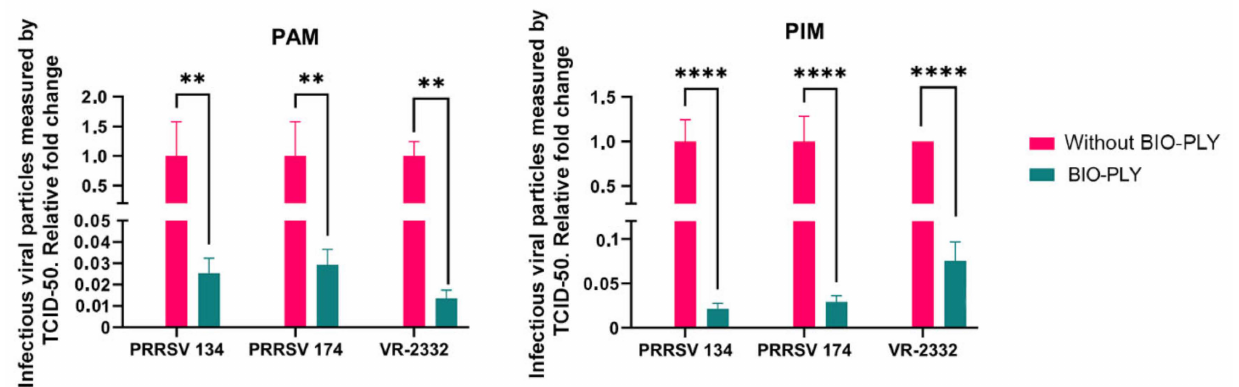
Figure 3. Effect of BIO-PLY TM treatment on the production of infectious viral particles in porcine alve- olar macrophages (PAM) and pulmonary intravascular macrophages (PIM) measured as TCID50/mL. Briefly, PAM and PIM were infected with PRRSV with and without BIO-PLY TM treatment. Super- natants were collected after 24 h of infection and used to perform TCID50 assays. All experiments were performed using technical duplicates in 3 biological replicates. Obtained values were normal- ized to the mean of the virus values without BIO-PLY treatment (set as 1) to reduce variation between biological samples and visualized as proportions based on the average values of infection. Results were analyzed via two-way ANOVA and displayed showing means and standard error of mean (SEM). p -values were expressed using asterisks following APA and Prism standards. ** p ≤ 0.01, **** p ≤